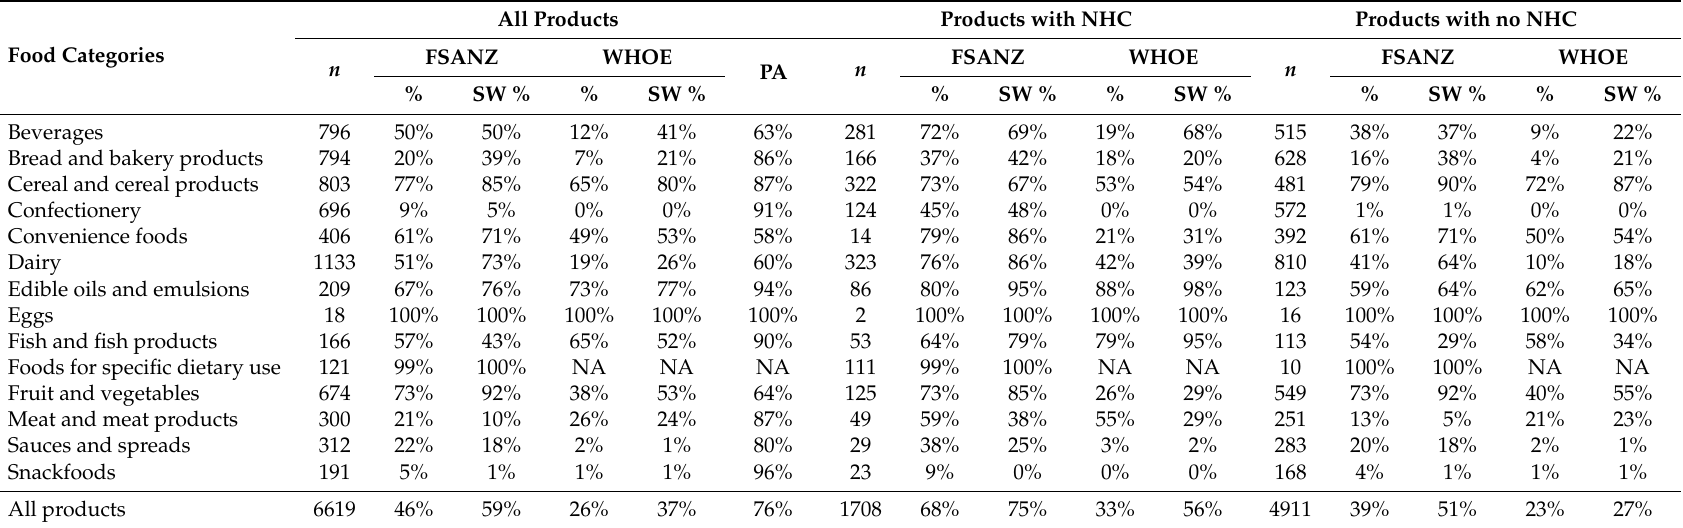
Table 4. Proportion of foods eligible by two nutrition profile models—Australia/New Zealand (FSANZ) and European World Health Organization Regional office for Europe model (WHOE); per category (all products, products with claims, and products without claims) and the difference with sales weighted